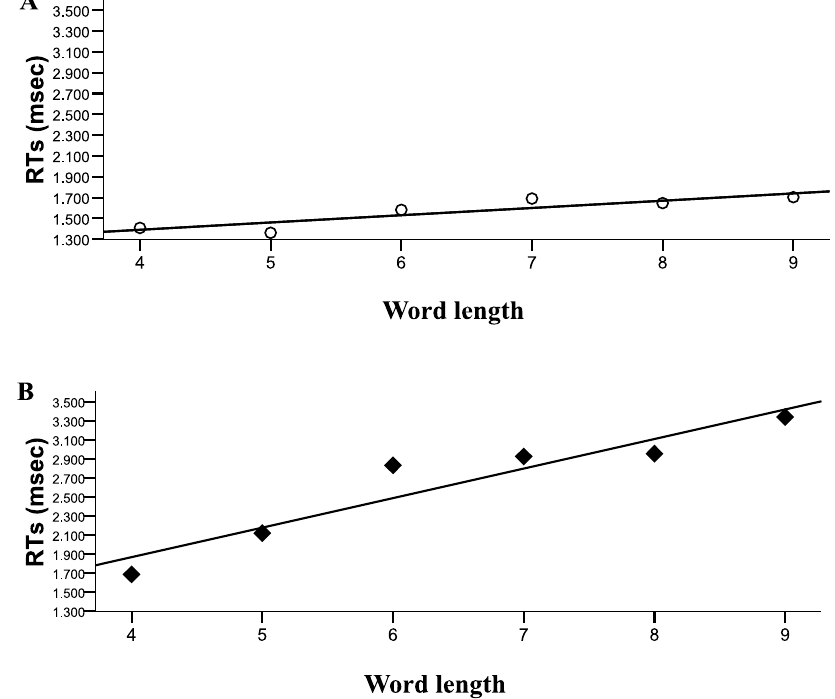
Fig. 2. Scattergrams showing the relationship between L.P. reaction times of words and word length for both periods. A = fi rst examination corresponding to 8 months from the disease onset ; B = second examination corresponding to 4 years from the disease onset. L.P. was followed from the early stages of